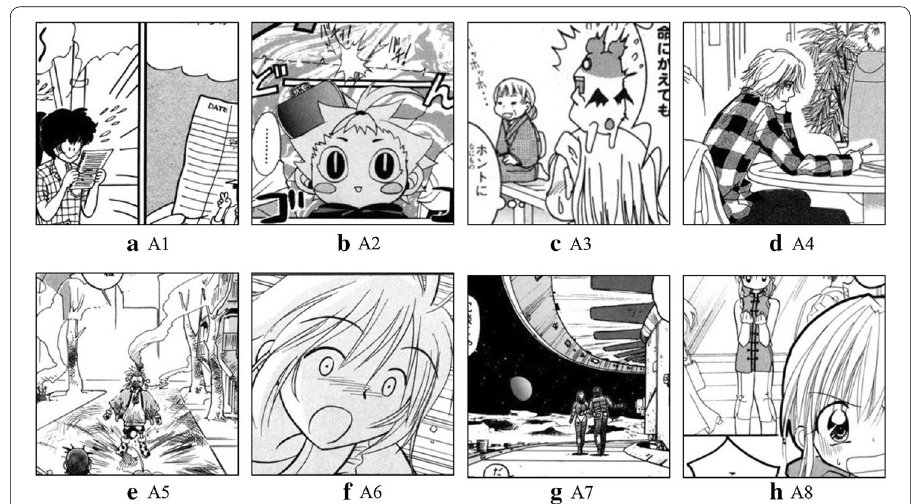
Fig. 2 Panel image examples after post‑processing